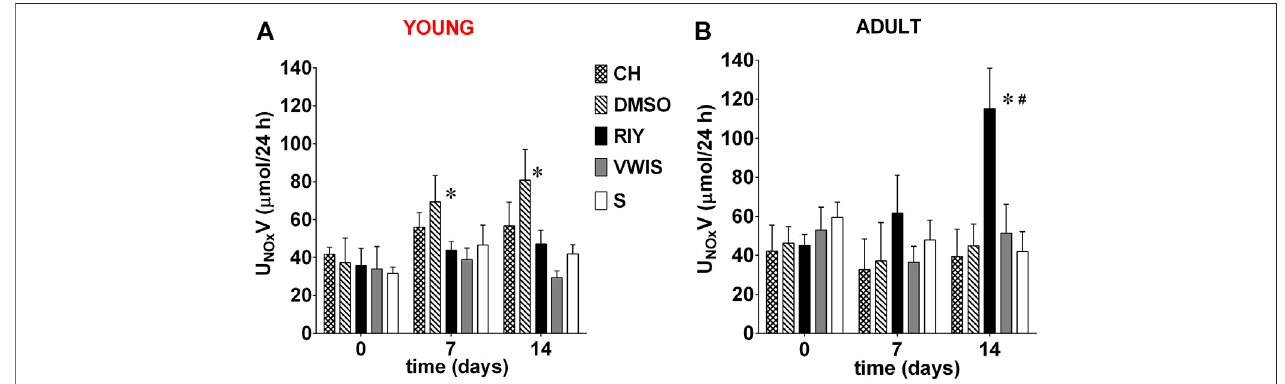
FIGURE 4 | Excretion of nitric oxide metabolites (U NOx V) measured on 0, 7th and 14th day in (A) young and (B) adult spontaneously hypertensive rats (SHR) receiving intravenous treatment with chymostatin (CH, 2 mg/kg/day, young: n (cid:1) 6, adult: n (cid:1) 8), its solvent (0.15% DMSO, young: n (cid:1) 6, adult: n (cid:1) 5); peptides RIY (7.5 mg/kg/day,young: n (cid:1) 5,adult: n (cid:1) 5),VWIS(12.5 mg/kg/day,young: n (cid:1) 5,adult: n (cid:1) 5)andtheirsolvent – saline(S,young: n (cid:1) 5,adult: n (cid:1) 4);* p < 0.05signi fi cantly different vs. baselinevalue on day 0within each group; # signi fi cantly different for RIY-treated group vs. values in all other groups on 14 days ( p < 0.05; multivariate analysis of variance ANOVA with repeated measurements, followed by Dunnet ’ s post-hoc test).